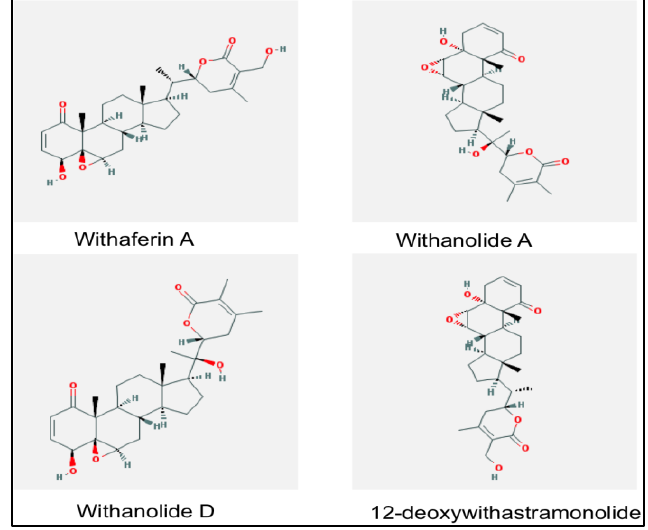
Figure 1. Steroidal lactones of Withania somnifera. Chemical structures were taken from the PubChem Substance and Compound database (pubchem.ncbi.nlm.nih.gov). The unique chemical structure identifiers are: 265237 (Withaferin A-Depositor: Chembase.cn) [34], 11294368 (Withanolide A-Depositor: Chembase.cn) [35], 161671 (Withanolide